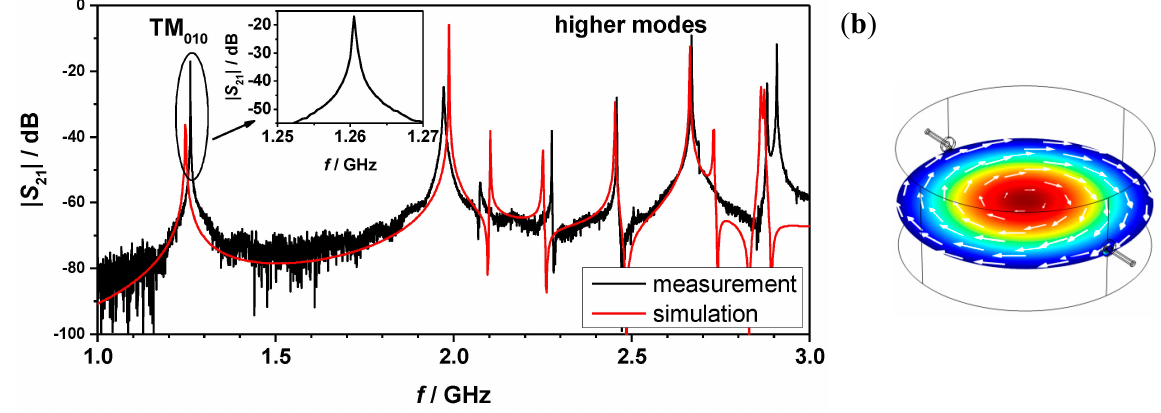
between 1 and 3 GHz: 21 mode ( b 010